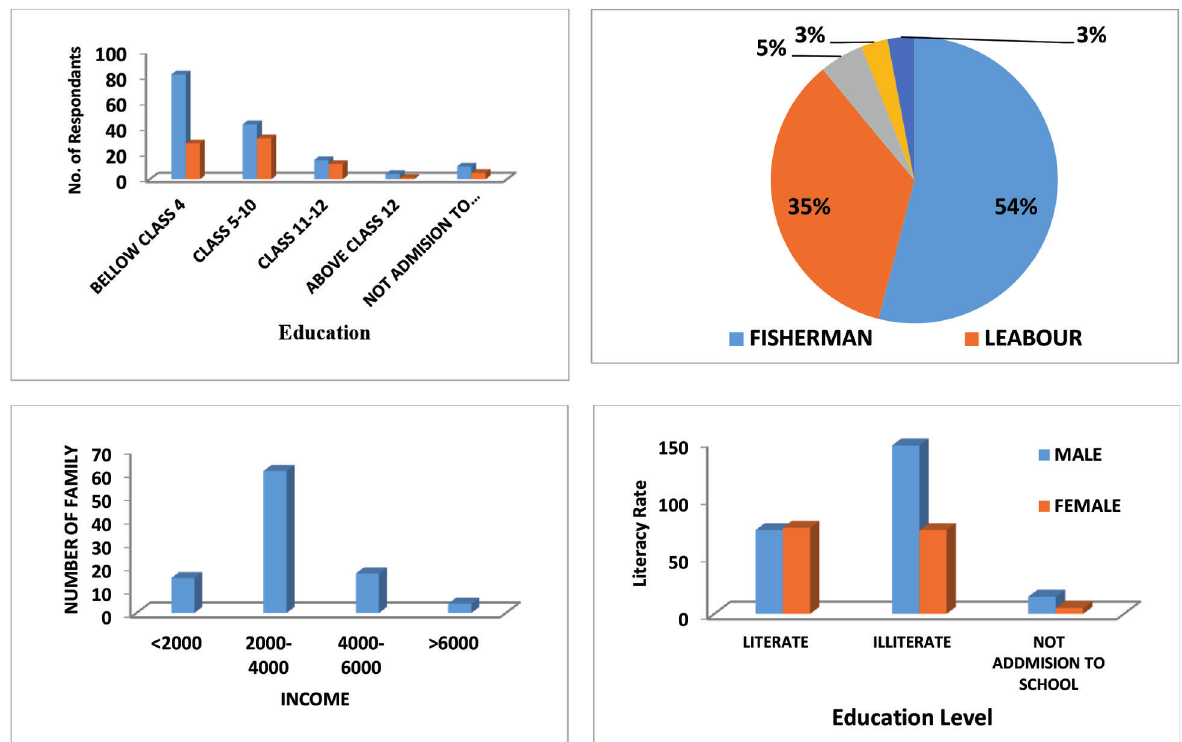
Fig. 4. Male and female wise educational, income, occupational status of the study